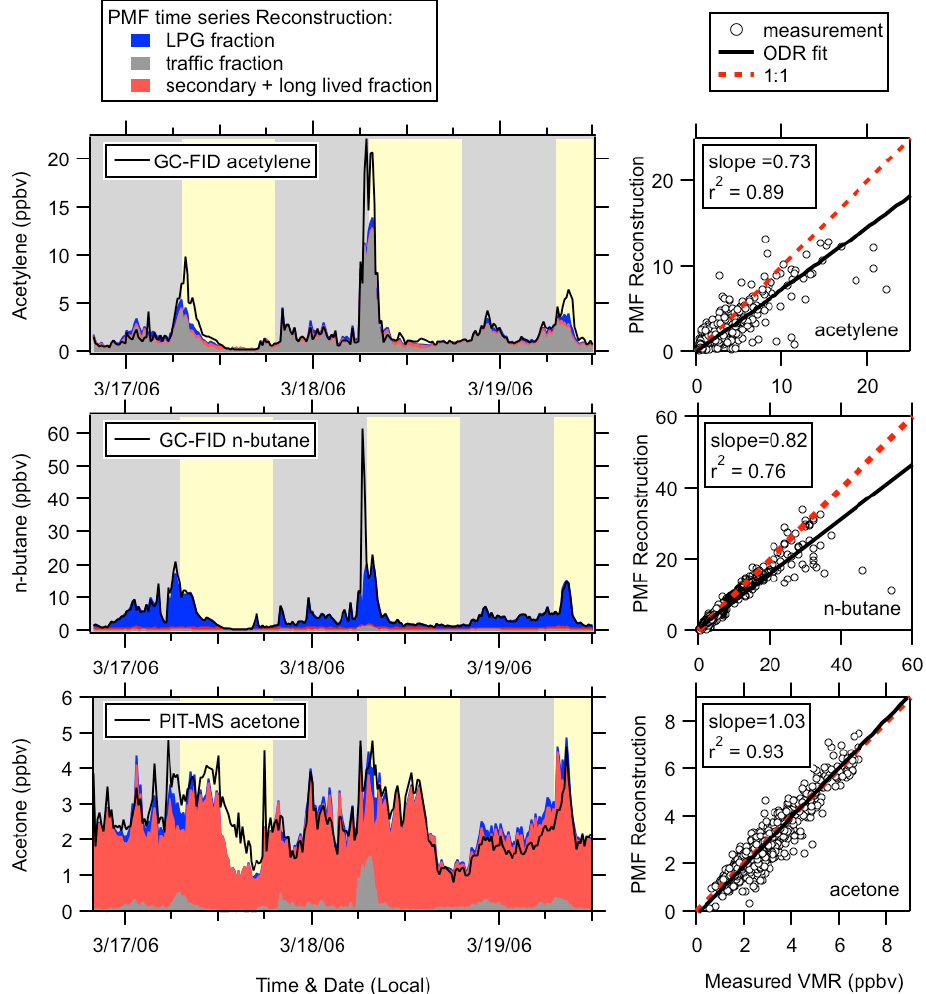
Figure 12. Selected comparisons between measurements and PMF reconstructions for one period during the MILAGRO campaign. The left column shows time series for representative compounds with dominant apportionment to the traffic factor (acetylene), the LPG factor (n- butane) and the secondary+long-lived factor (acetone). Measurements are shown as solid black traces for comparison. On the right are scatter plots of PMF reconstructions (FPEAK 0) versus measurements showing single-sided fits (black) and 1:1 lines (red) for the same compounds.